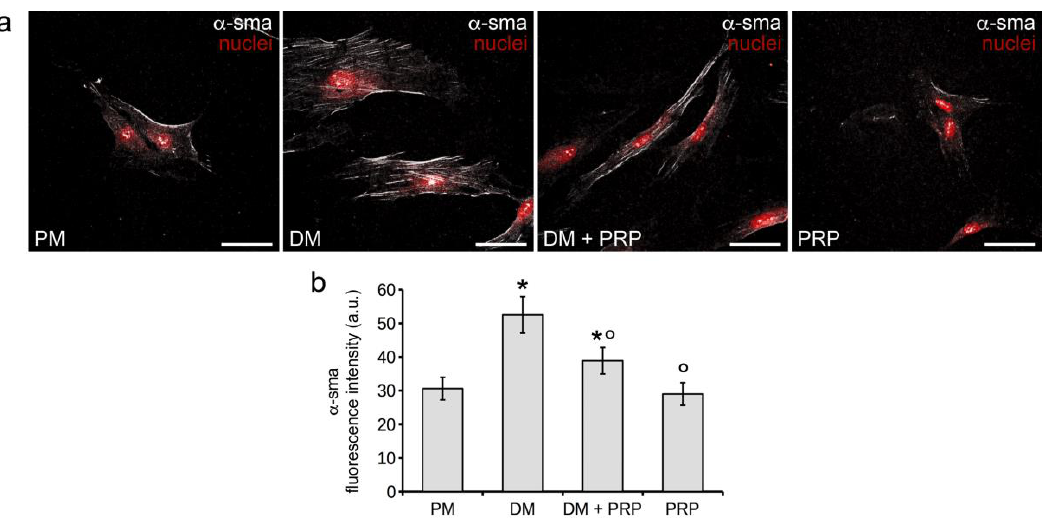
Figure 2. Evaluation of human HDF α fibroblast to myofibroblast transition. The cells were induced to differentiate towards myofibroblasts by culturing for 48 h in differentiation medium (DM, low serum medium plus 2 ng/mL TGF- β 1). Cells cultured in proliferation medium (PM) served as control undifferentiated cells. To evaluate the effects of PRP on TGF- β 1-induced fibroblast-myofibroblast transition, cells were cultured in DM added with 1:50 diluted PRP (DM + PRP). In addition, the cells were cultured in the presence of 1:50 serum-free medium diluted PRP (PRP). ( a ) Representative confocal fluorescence images of the cells immunostained with antibodies against α -sma and counterstained with propidium iodide to label nuclei. Scale bar: 50 µ m. ( b ) Histogram showing the densitometric analyses of the intensity of α -sma fluorescence signal performed on digitized images. Data shown are mean ± S.E.M. and represent the results of at least three independent experiments performed in triplicate. Significance of difference: * p < 0.05 vs. PM; ° p < 0.05 vs. DM.